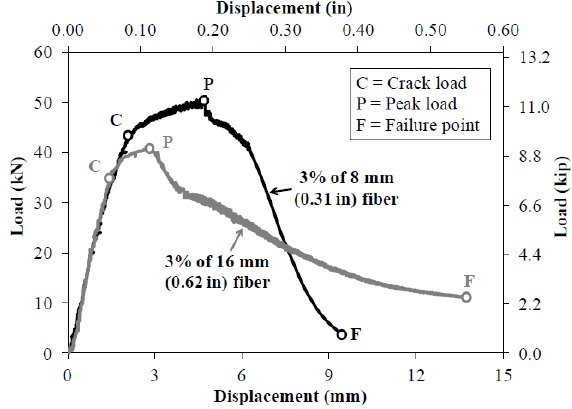
Figure 7: Load-displacement curve from flexural testing Abbas [37]